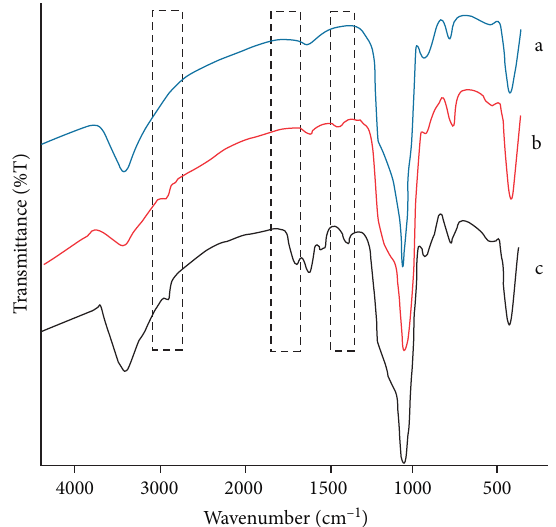
Figure 4: FTIR spectra: (a) MSNs, (b) MSN-GPTS, and (c) MSN-Cys.